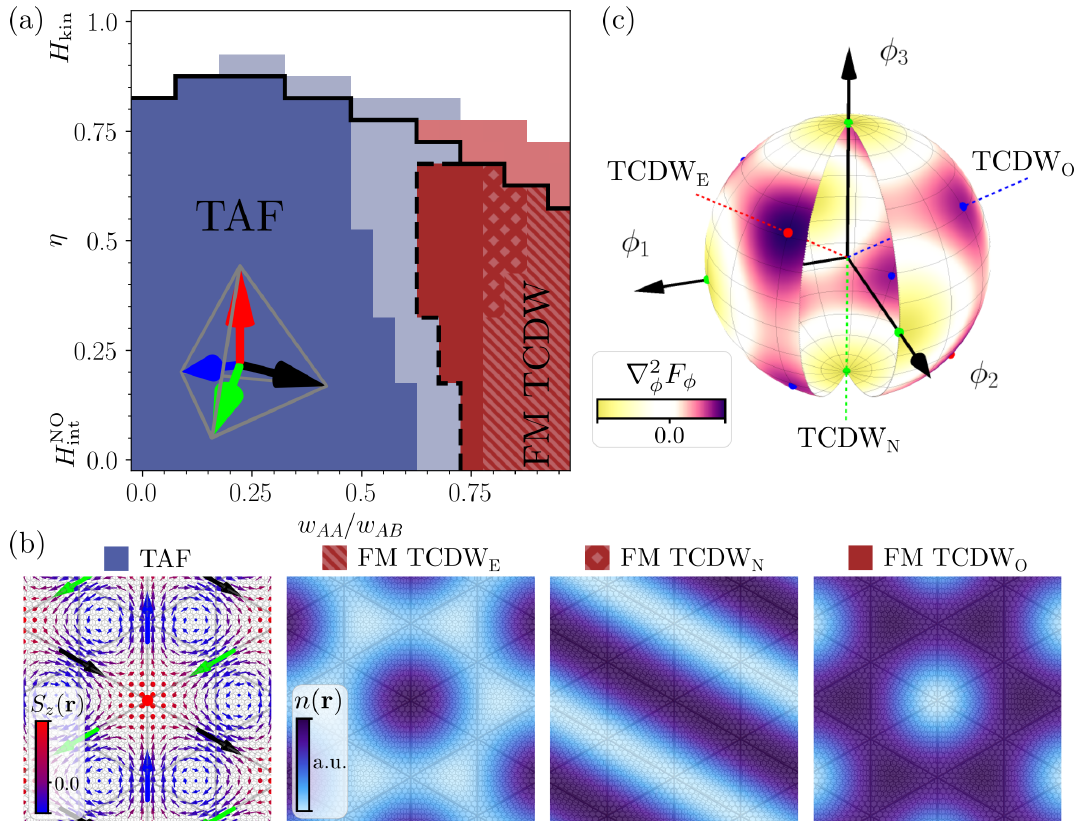
Figure 1: (a) Phase diagram of twisted double-bilayer graphene at conduction band filling ν “ 1 { 2 as a function of the moiré relaxation ratio w ling the interaction strength, based on the combined data from exact diagonalization and Hartree-Fock. As illustrated in (b), the system realizes a tetrahedral antiferro- magnetic (TAF) spin texture in a large parameter regime. At large values of w a ferromagnetic topological charge density wave (TCDW) with an approximate O p 3 q symmetry emerges. Both types of order break time-reversal symmetry and exhibit a finite, quantized Hall conductance. (c) Illustration of the O p 3 q TCDW manifold with exemplary anisotropies. Minor cubic and quartic anisotropies select between even (E), odd (O) and nematic (N) realizations of charge